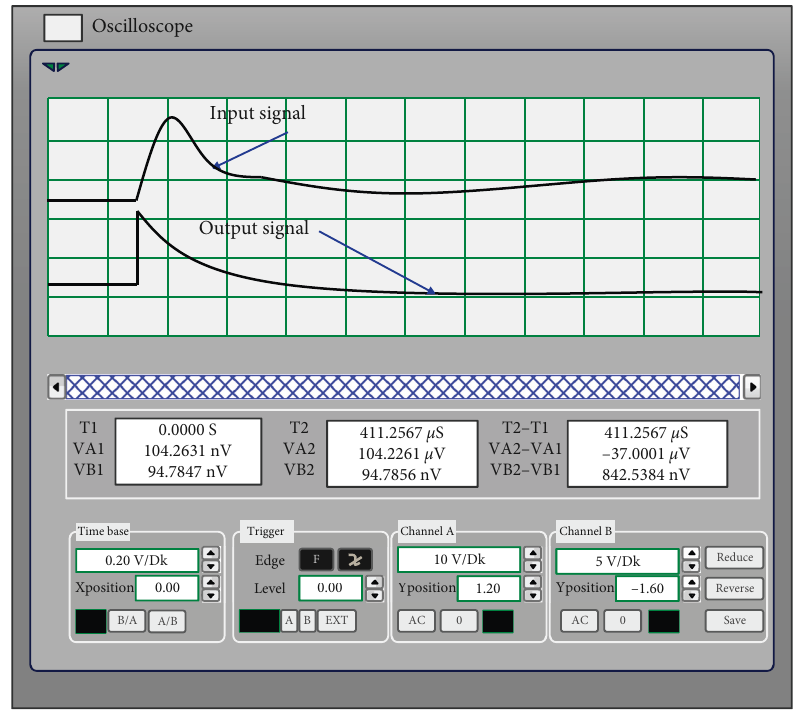
Figure 4: Simulation results of Gaussian forming of the single-stage S–K device.